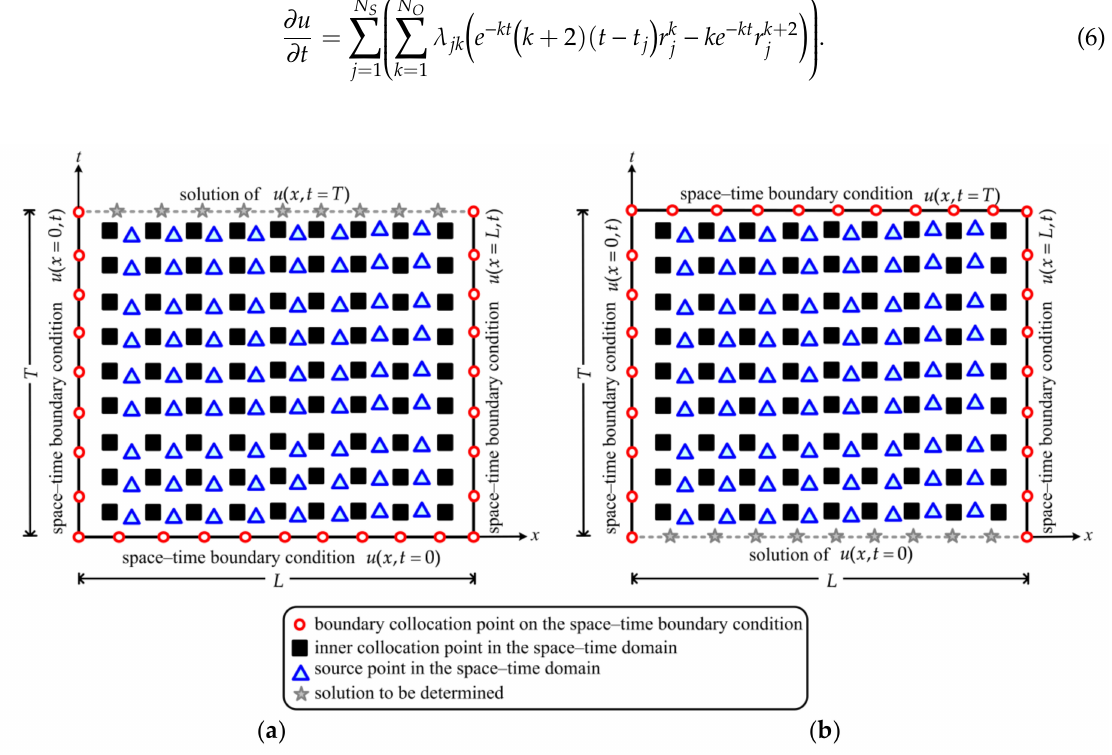
Figure 2. Illustration of the space–time collocation scheme: ( a ) The direct heat conduction problem (DHCP); ( b ) The backward heat conduction problem